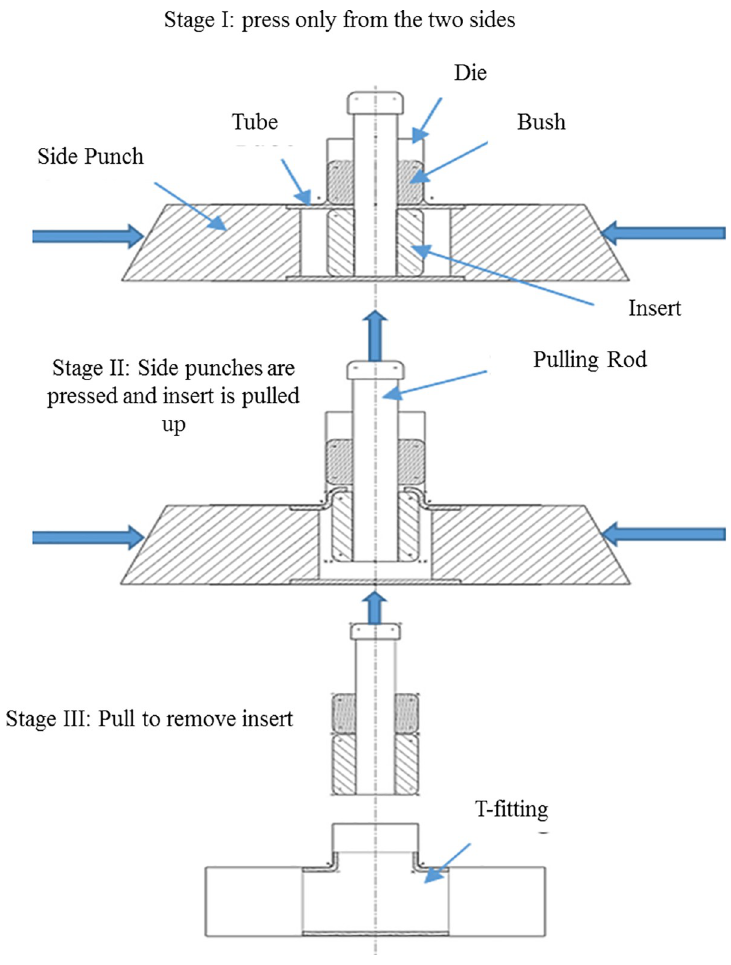
Fig 2. Production of a T-tube